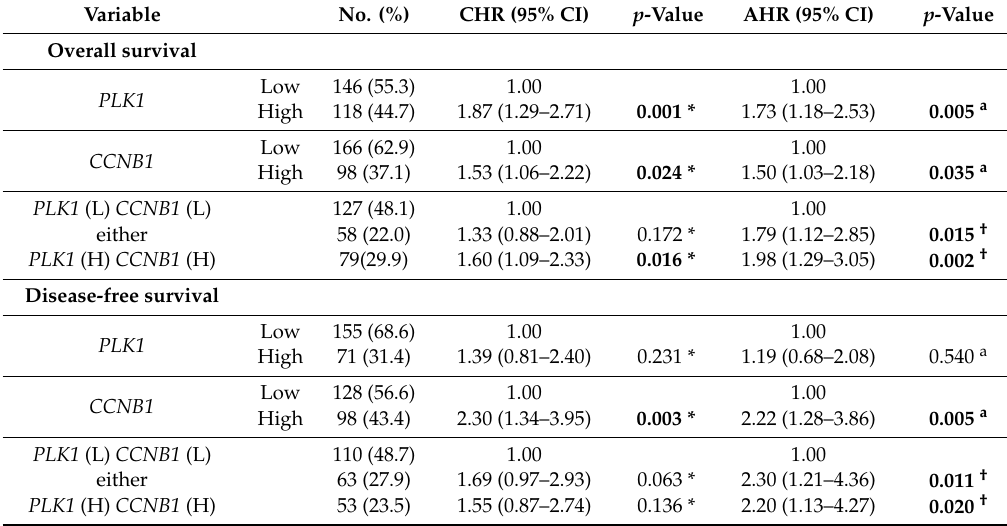
Table 4. Impact of expression levels of PLK1 and CCNB1 on survival by the di ff erent demographic and clinicopathologic factors with